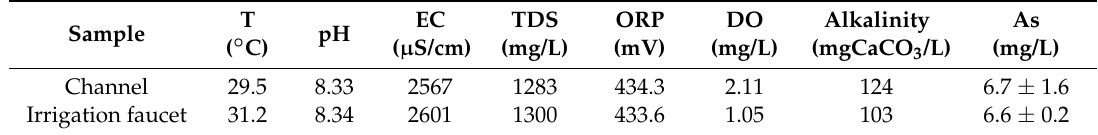
Table 2. Physicochemical characterization of the irrigation